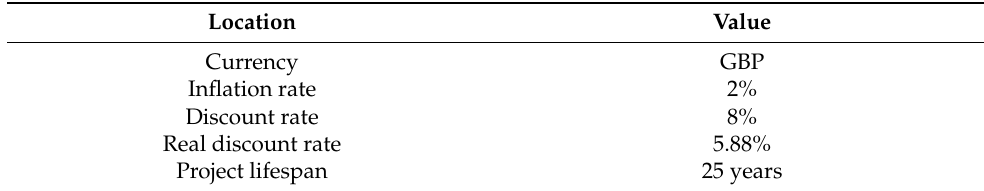
Table 6. Other input parameters.